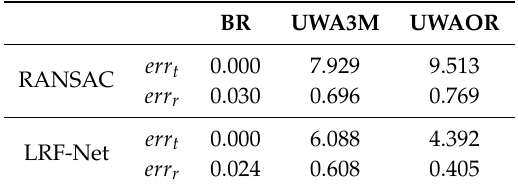
Table 4. Six-degree-of-free (6-DoF) pose estimation performance on three experimental